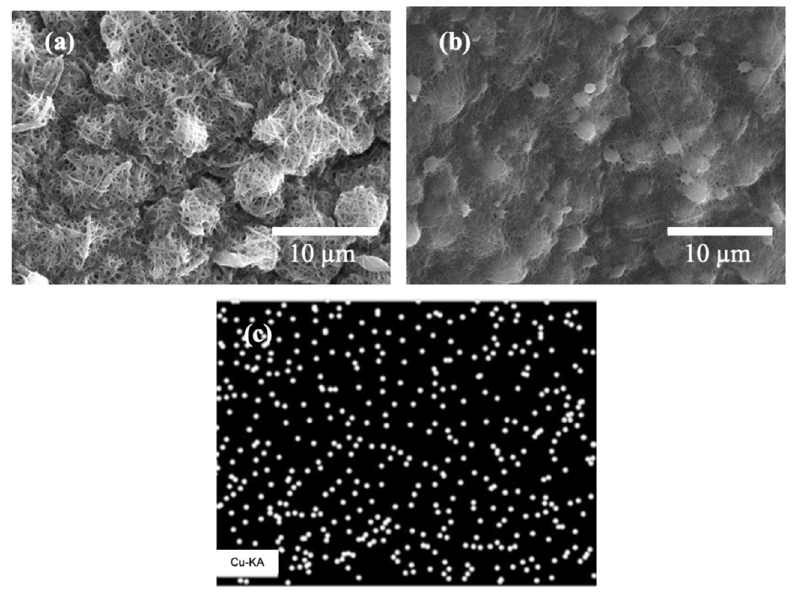
Figure 7. SEM images of PEI-CS/PCL_60s nanofibers: ( a ) before; and ( b ) after exposed to copper- containing solution, with ( c ) elemental mapping of Cu. Table 2. Adsorption of copper onto PEI-CS/PCL_60s membrane.